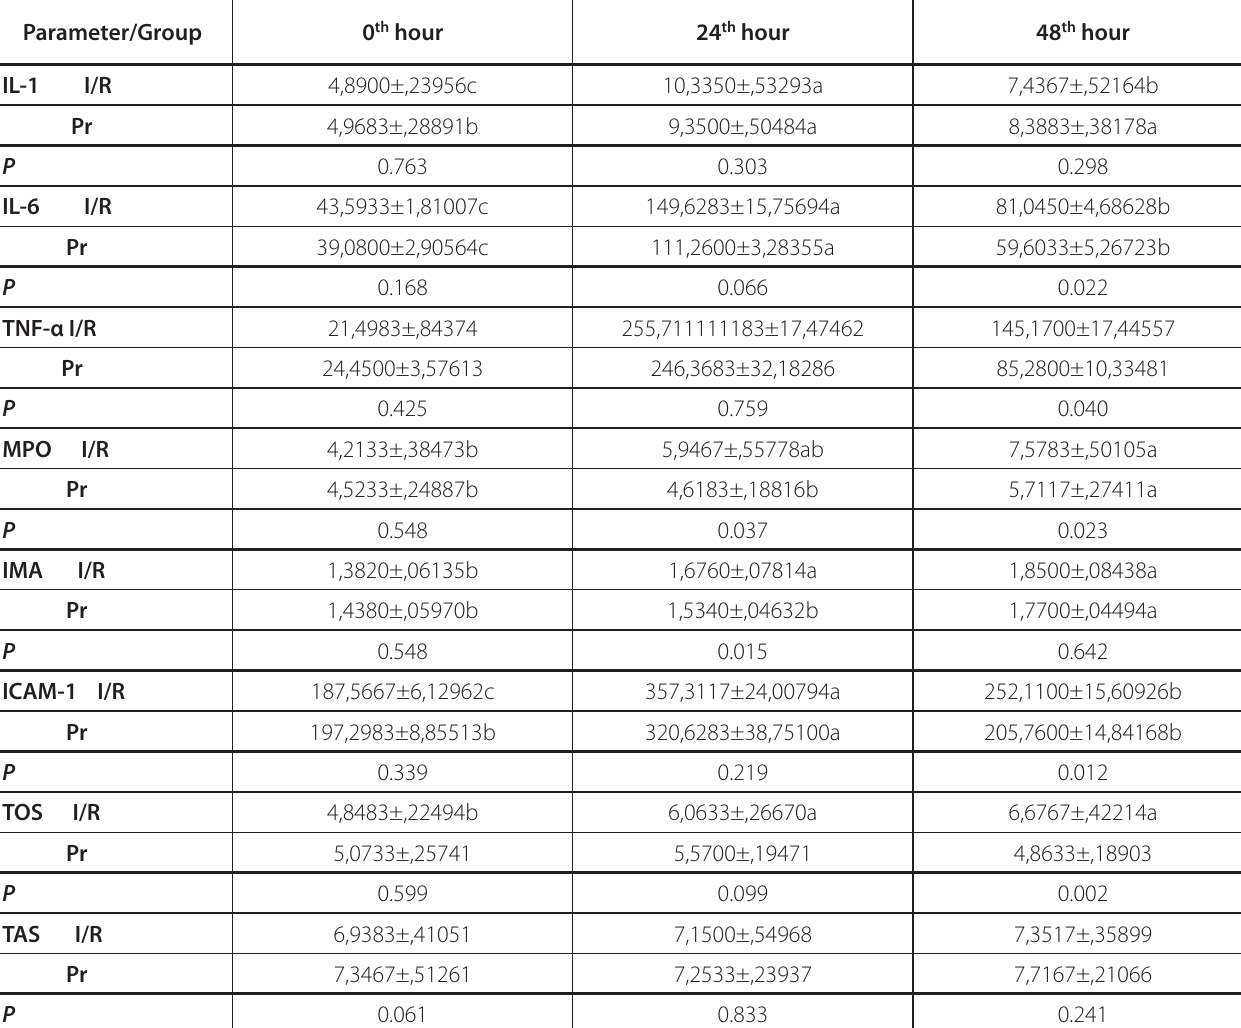
Table 3 . Biochemical analysis results in groups (mean±SD).